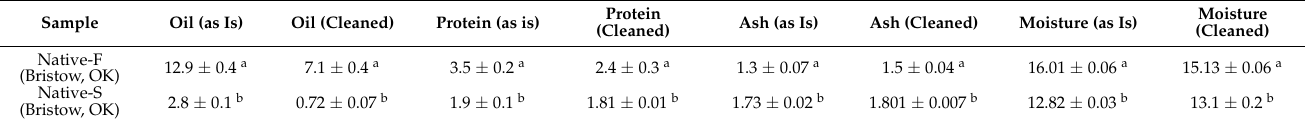
Table 4. Proximate composition (weight %) of pecan shelling industry byproducts as received from the processing facility and hand separation of nut meat pieces